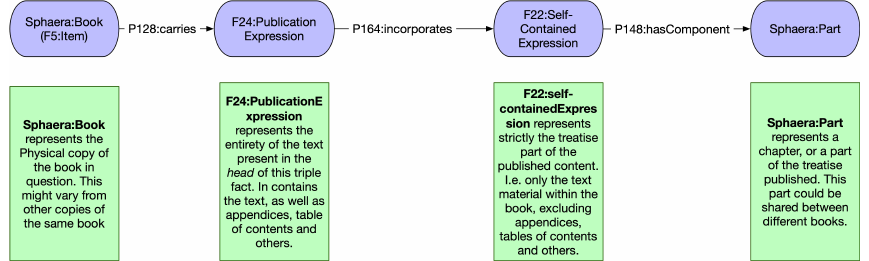
Figure 2. Path expressing the relation between a book and a book part in the Sphaera